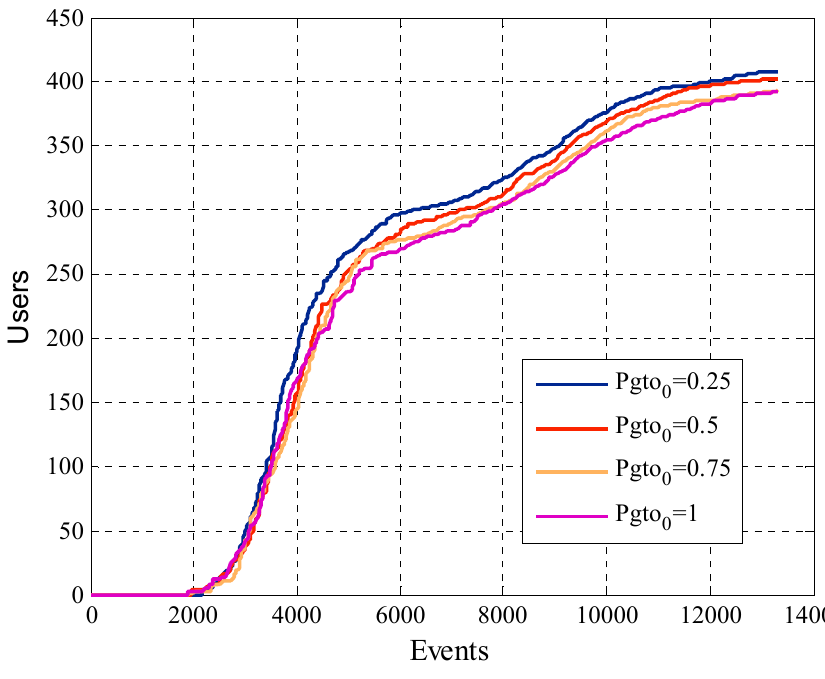
Figure 12. Amount of removed users for configurations with di ff erent values of Pgto 0